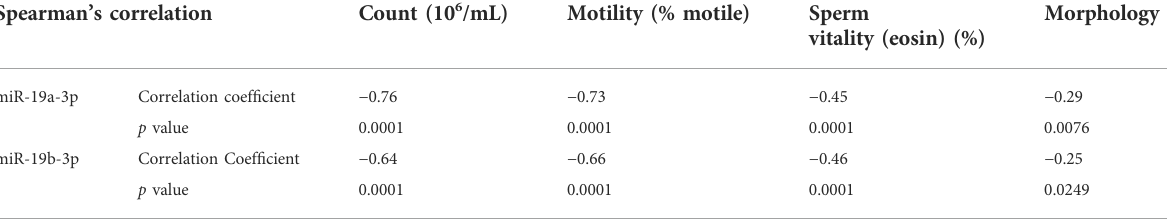
TABLE 3 Correlation analysis between the expression level of miRNAs and basic semen parameters. Spearman ’ s